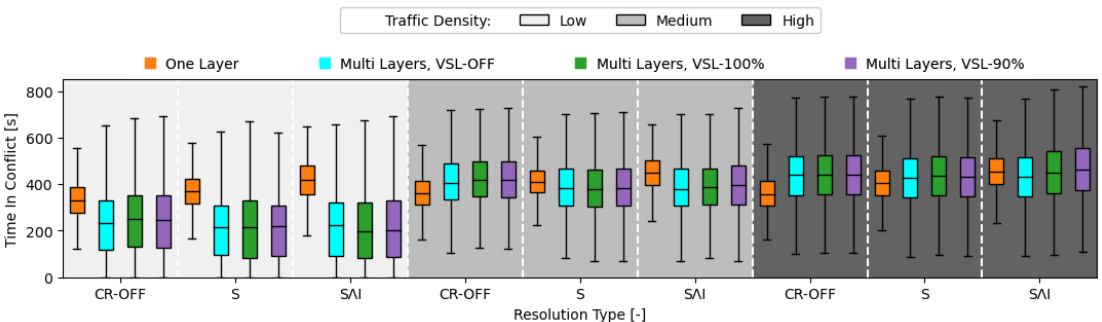
Figure 18. Total time in conflict per